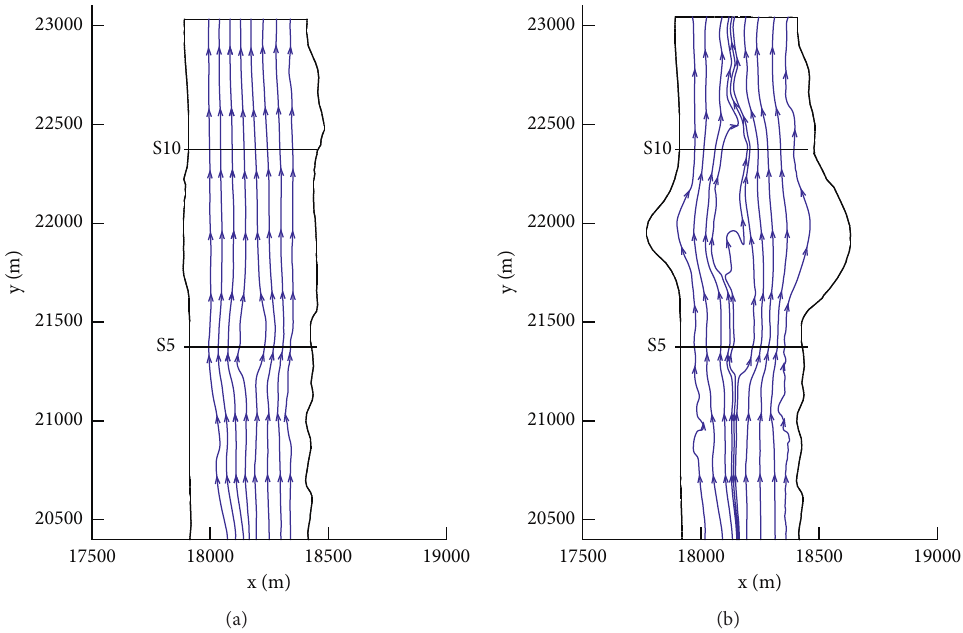
Figure 10: Comparisons of streamlines before and after river reconstruction for a 100-year flood. (a) Before reconstruction. (b) After